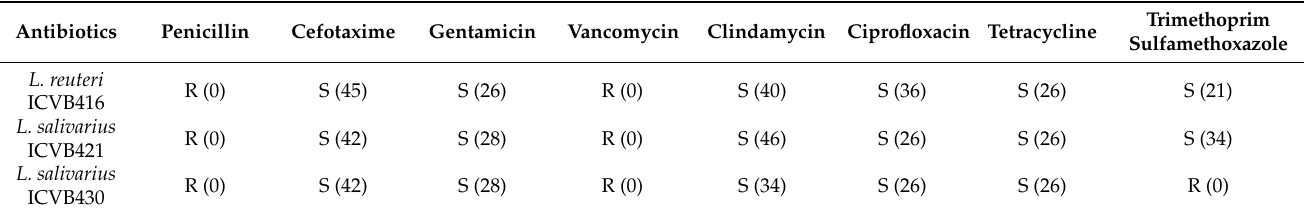
Table 1. Antibiograms of Lactobacillaceae strains tested in vivo . The sizes of inhibition zones are indicated in mm between